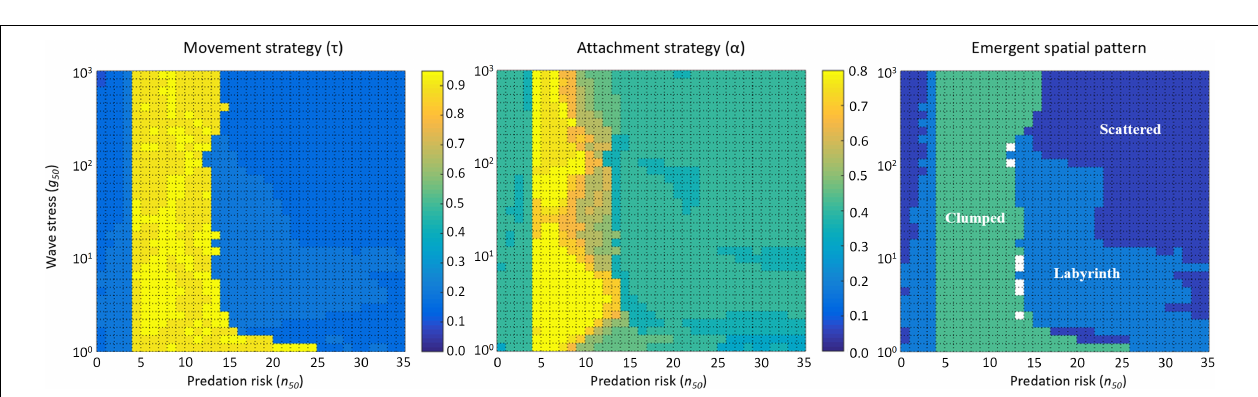
FIGURE 5 | Simulations with various combinations of predation risk ( n 50 ) and wave stress ( g 50 ) produce qualitatively different evolutionary outcomes. Left , Middle , and Right panels show the evolved movement strategy ( τ ), the evolved attachment strategy ( α ), and the emergent spatial pattern, respectively, for different combinations of predation risk ( n 50 ) and wave stress ( g 50 ). Here, κ 1 = 0.001 and κ 2 = 0.01.